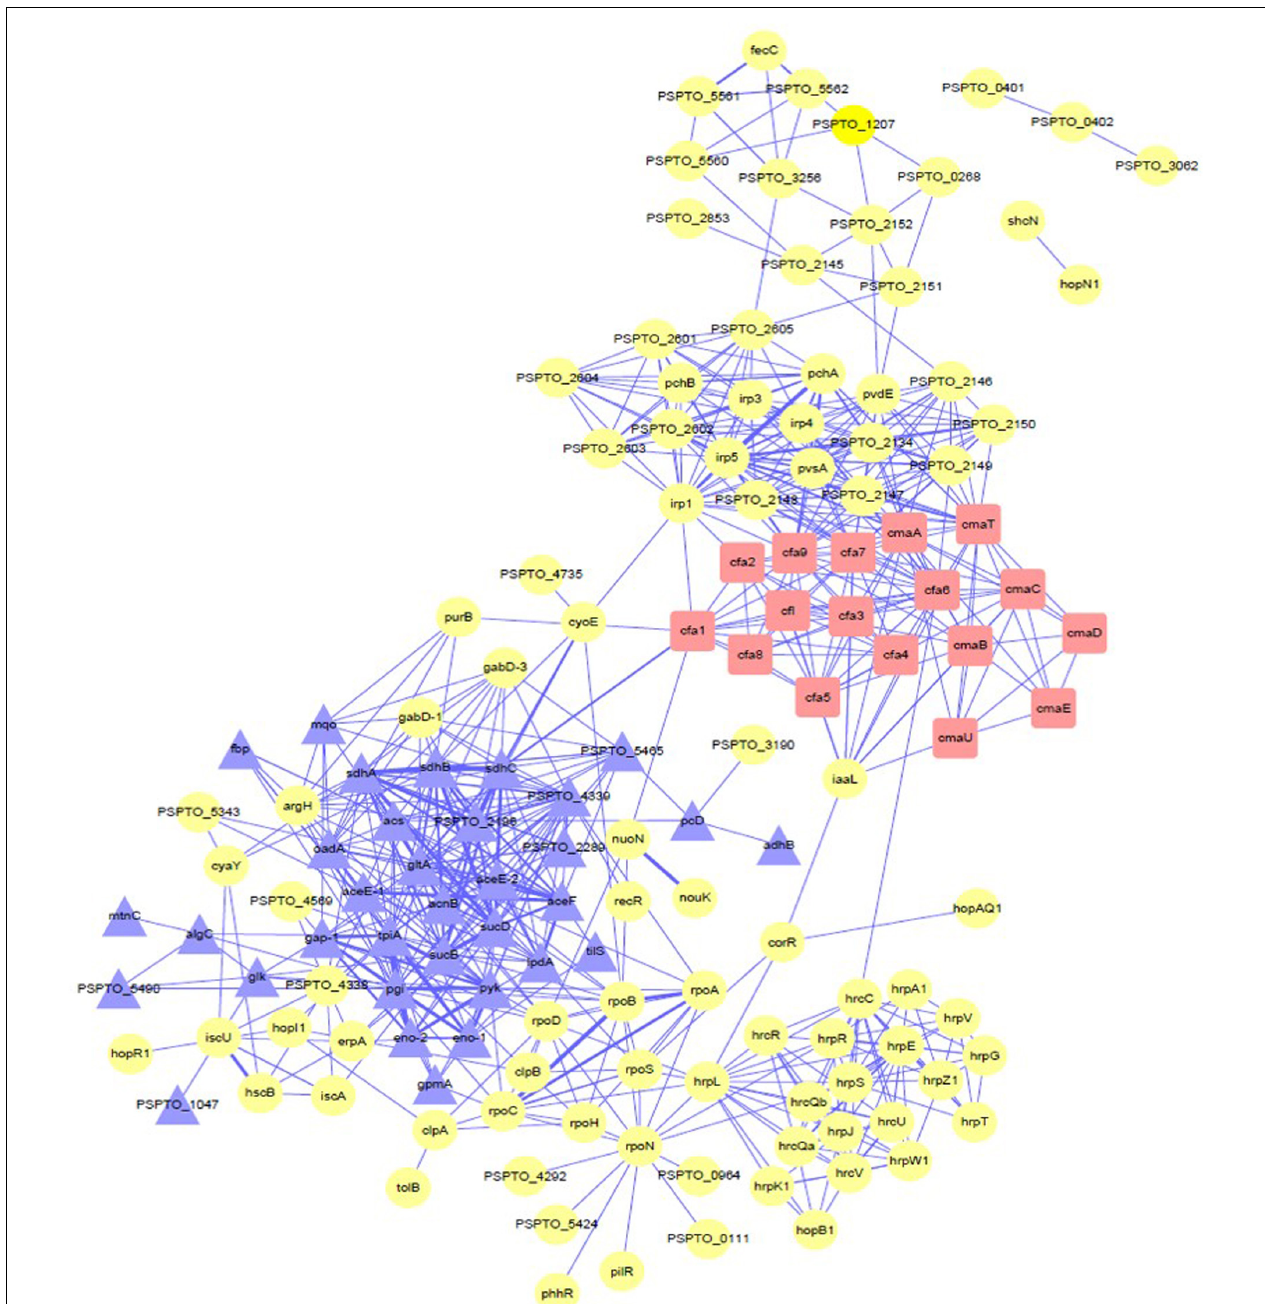
FIGURE 7 | PPI network analysis showing the relationships between the differentially significant proteins. The red squares represent coronatine synthesis-related proteins. Yellow circles represent proteins associated with iron ions. Purple triangles represent proteins of the tricarboxylic acid cycle and glycolysis. Detailed data are presented in Supplementary Table S2 . PPI network analysis used STRING and Cytoscape (Version